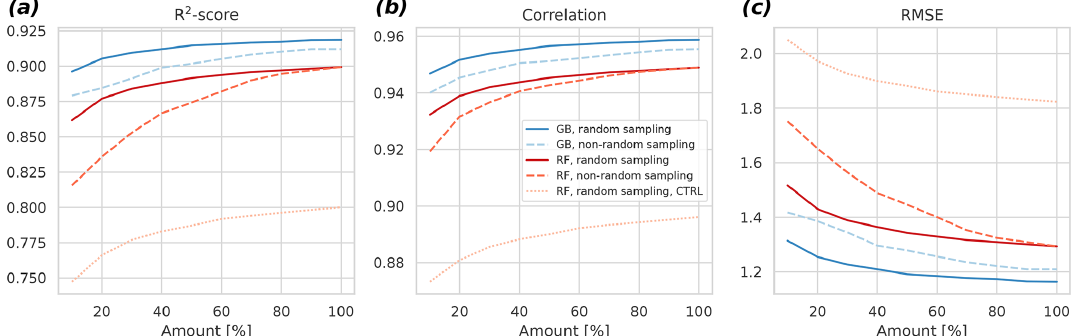
Figure 5. Cross-validated R 2 score (a) , the Pearson correlation coefficient (b) , and the root mean square error (c) as a function of the amount of fitting data for the gradient boosting approach (blue) and the random forest approach (red). Different subsampling approaches (random versus non-random) are also shown with different dashes. The control experiment – a fit without spatiotemporal neighbors – is shown for the random forest approach. The control for the gradient boosting fails to fit properly with the limited predictors, and it is not shown for this reason. Averages of 6h were used in this